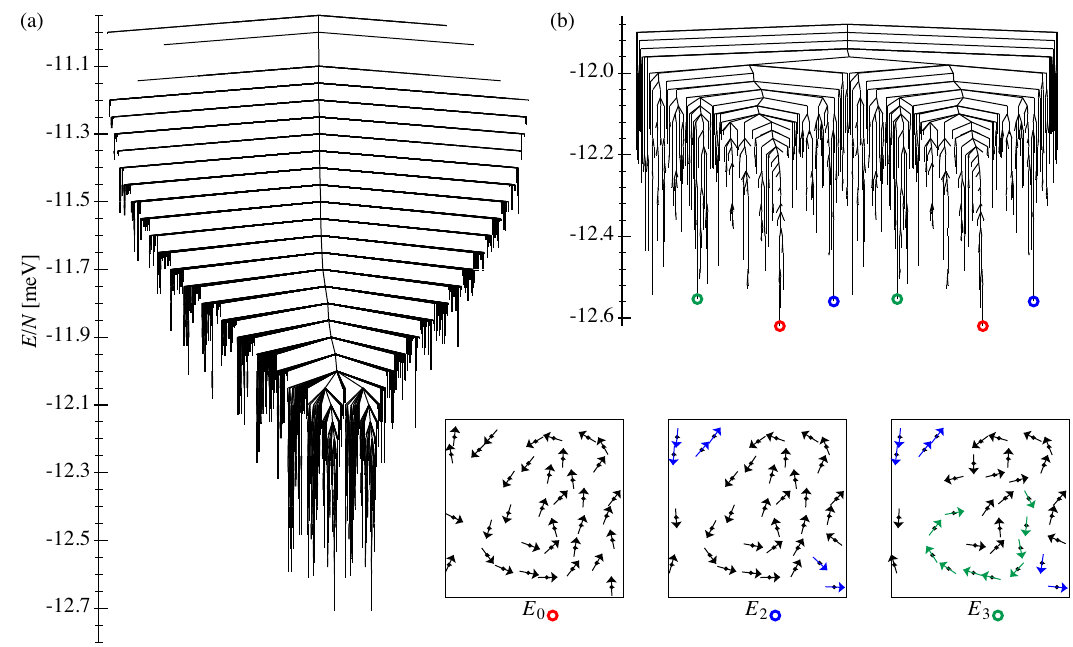
FIG. 7. Disconnectivity graph of the strongly disordered ensemble of nonoverlapping NPs illustrated in Fig. 1(c). In graph (a), all calculated LM are taken into account, whereas graph (b) focuses on the lowest 400 LM. Notice the numerous low-lying local minima, which are separated by important energy barriers that are often much larger than the energy differences between the LM. The energy barriers from the metastable minima towards the low-lying superbasins tend to decrease as the excitation energy increases. The insets illustrate the magnetic configuration in the ground state ( E 0 ) as well as the second ( E 2 ) and third ( E 3 ) excited configurations. The first excited configuration (not shown) is very similar to the ground state